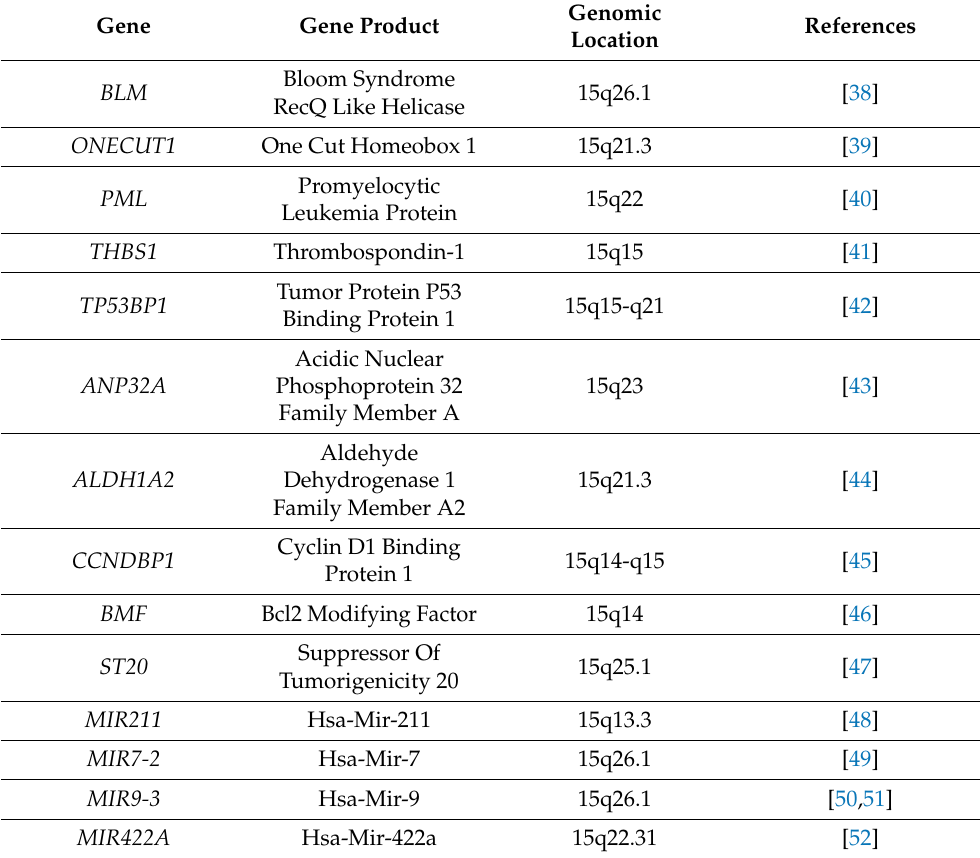
Table 2. List of tumor suppressor genes comprised within the region 15q. Gene Gene Product